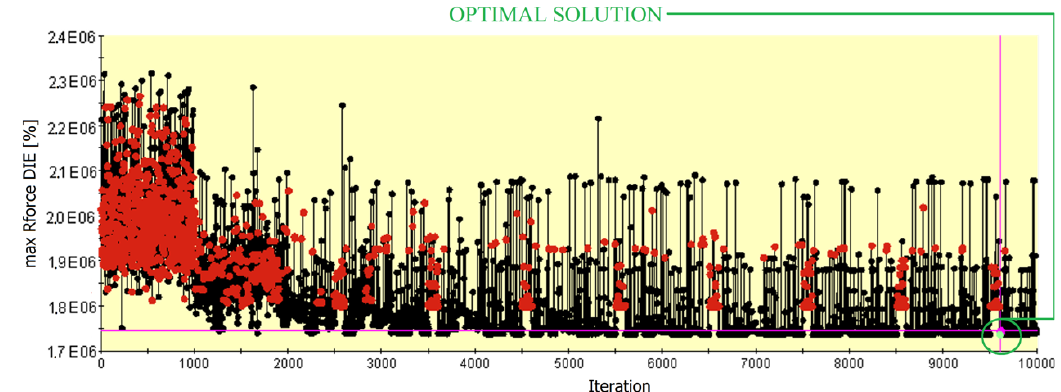
Figure 25. Design explored with multi-island genetic algorithm (MIGA), blank0 plan.